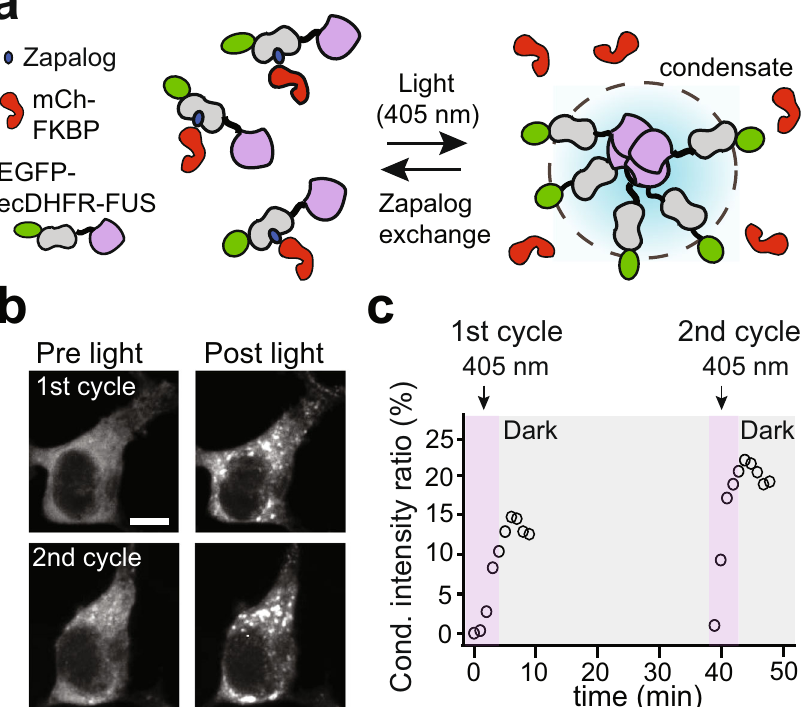
Fig. 2 Use of DisCo with a photocleavable dimerizer allows reversible control of FUS condensate formation and disruption. a Schematic showing use of the photocleavable heterodimerizer zapalog to reversibly control FUS condensate disruption. b Representative cell expressing EGFP-ecDHFR-FUS and mCh-FKBP incubated with 500 nM zapalog. Prior to illumination, FUS condensates are prevented from formation by C-BLOCK binding. Approximately 2 – 3 min after illumination with 405 nm light (50 ms pulse every 30 s for 5 min), FUS condensates can clearly be observed. After light treatment, incubation with zapalog in the dark for 34 min allows binding of uncleaved zapalog from the media and restores condensate blocking effect. A second round of 405 nm illumination induced further FUS condensate formation. The experiment was repeated an additional time with similar results. Scale bar, 10 µ m. c Quanti fi cation of EGFP-ecDHFR-FUS condensate formation for experiment in ( b ), with data shown from a single